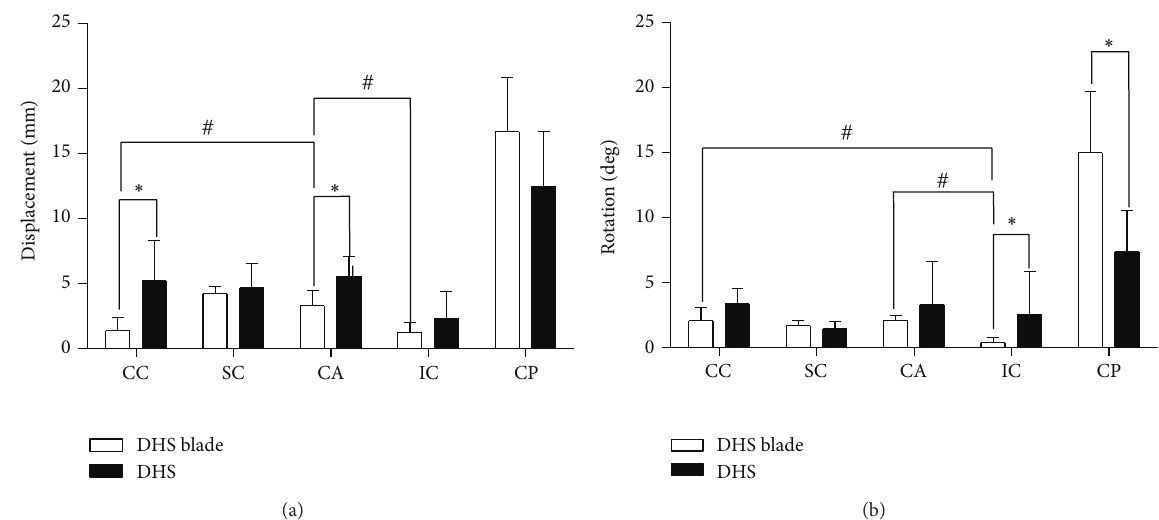
Figure 5: Results of comparing DHS blade (group 1) and conventional DHS (group 2) of five implant positions by Mann-Whitney U test with statistic significant ∗ 𝑃 < 0.05 and results in comparing vertical displacement and rotation in 3 different implant positions in DHS blade group by Mann-Whitney U test with statistical significant # 𝑃 < 0.05